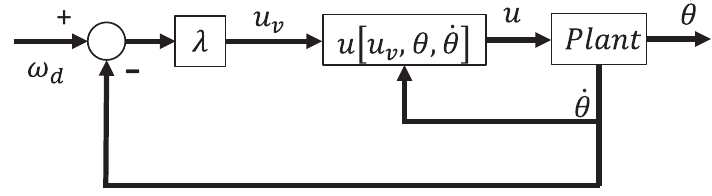
Figure 5. Spring Contact Basketball Robot